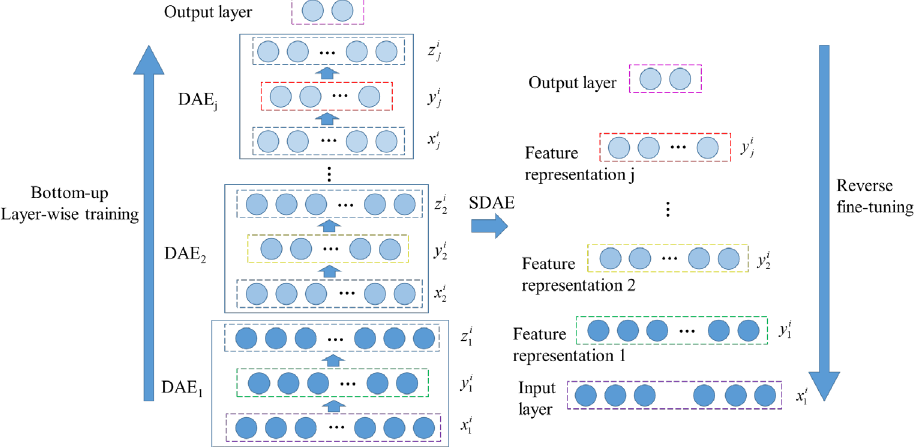
Figure 8. Schematic diagram of the training process of SDAE.